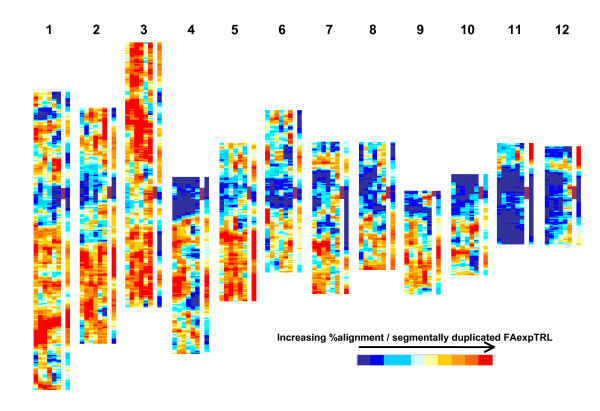
Heat maps for % sequence alignments and segmentally duplicated rice loci. Colour coded moving windows/100 functionally annotated, expressed TIGR rice loci (MWs/FAexpTRL) for each rice pseudomolecule (1–12). For each pseudomolecule: column 1–6 = MWs for % significant MegaBLAST alignments between Os_CD and test databases Lp_MF, Zm_MF, Zm_TA, Hv_TA, Gm_TA and AT_TA, respectively; column 7 = position of MWs containing rice centromere (dark vertical bar); column 8 = MWs indicating the distribution of segmentally duplicated FAexpTRL [see Additional file 2 Table 3 for colour code quantification].